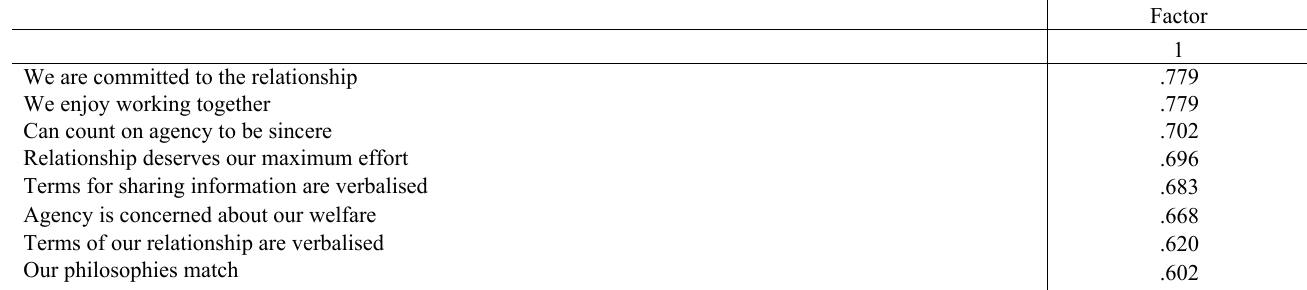
Table 6: Good working relationship factor